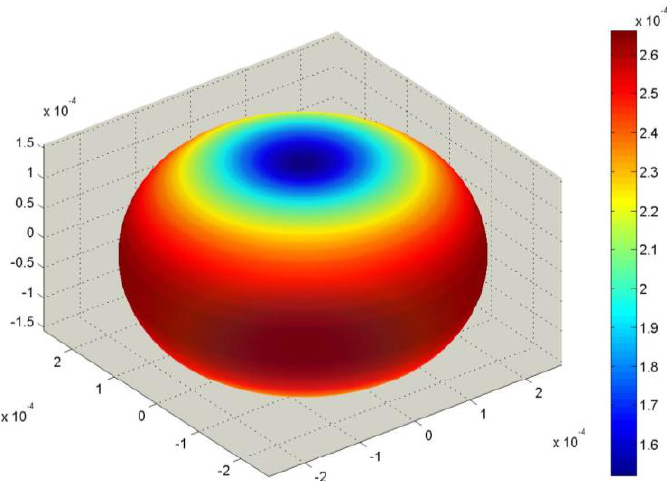
Figure 8. Longitudinal surface representation, ε textured polycrystal.